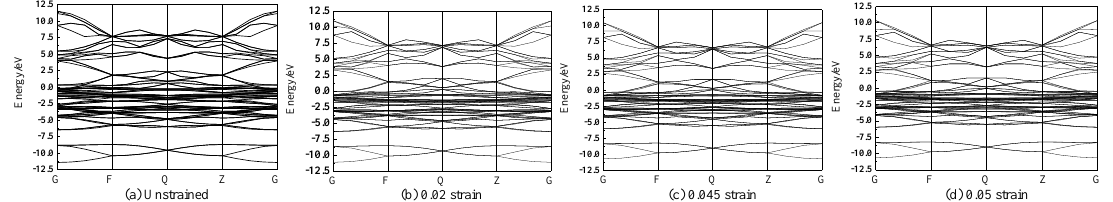
Figure 7. The change in band structure in the process of DO3 placed under triaxial tensile strains. ( a ) unstrained, ( b ) 0.02 strain, ( c ) 0.045 strain and ( d ) 0.05 strain.